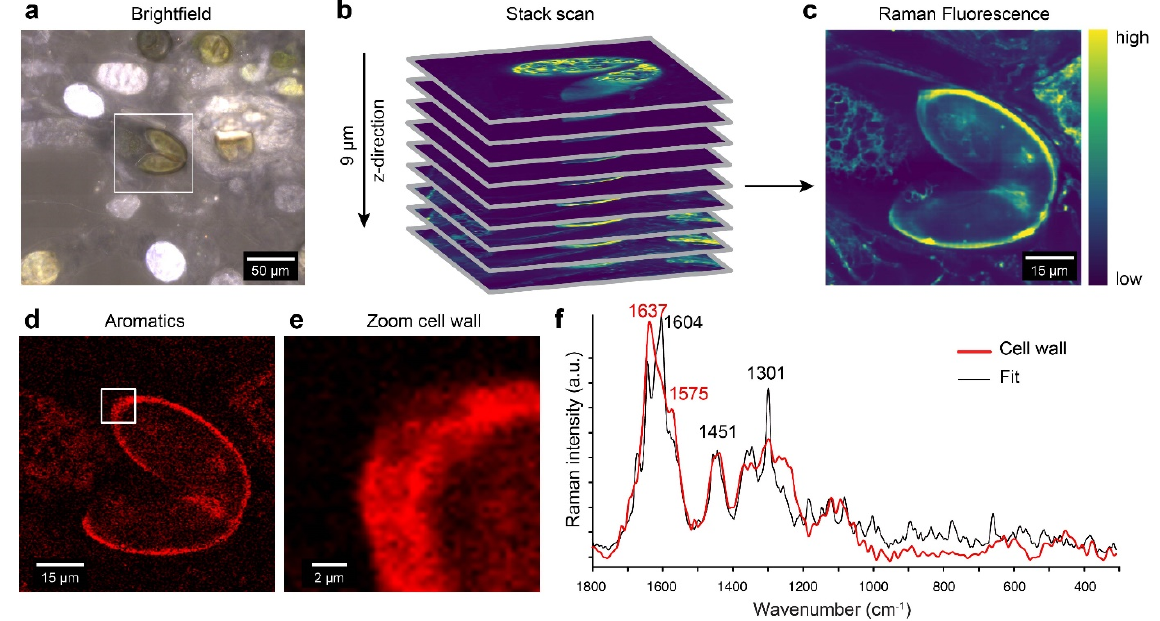
Figure 7. Raman imaging of Spirogyra mirabilis zygospores reveals aromatic compounds in the cell wall. ( a ) Brightfield image of the investigated spore (white rectangle). ( b ) Confocal Raman images with a depth profiling of 9 µm, measured as nine layers in a stack for every micrometer in the z-direction, up to down. ( c ) Raman fluorescence image of the middle layer of the spore. ( d ) Aromatic compounds impregnate the cell wall as visualized by integrating the peak at 1604 cm − 1 . ( e ) Magnification of the cell wall shows high intensity of aromatic compounds in the zygospore cell wall, but no clear layering. ( f ) The extracted average spectrum from the Spirogyra cell wall (red line) shows clear aromatic bands around 1600 cm − 1 . Fitting of reference Raman spectra by a linear combination using the Orthogonal Matching Pursuit Method confirmed the aromatic nature and placed the Lycopodium spore cell wall spectrum on top with the highest contribution (similarity) (Supplementary Figure S4).